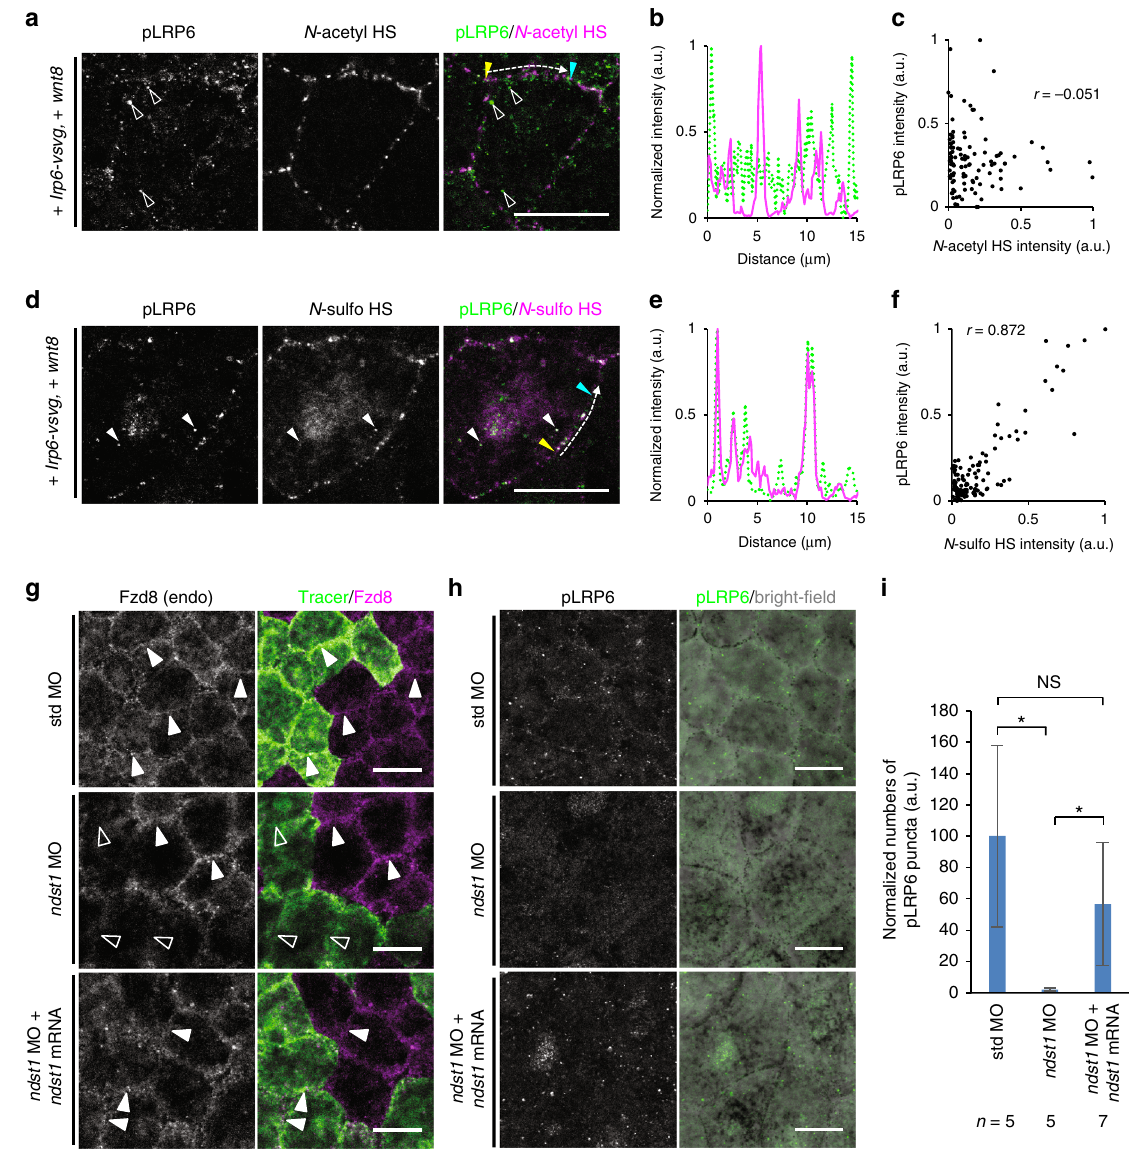
Fig. 8 N- sulfo-rich HS clusters are involved in the formation of the Wnt/LRP6 signalosome. a – f The colocalization of phosphorylated LRP6 (pLRP6) and N- sulfo-rich HS clusters. Together with Alexa Fluor 647-dextran (tracer, not shown), mRNAs of wnt8 and lrp6-vsvg were injected into the animal pole region of a ventral blastomere of 4- or 8-cell stage embryos. Signal intensities along white arrows were plotted ( b , e ), starting (yellow arrowheads) and ending (cyan arrowheads) points as indicated, respectively ( a , d ). Distributions of pLRP6 and N- acetyl HS were not correlated well (correlation coef fi cient r = − 0.051), whereas distributions of Wnt8 and N- sulfo HS were highly correlated ( r = 0.872). Note that pLRP6 staining is colocalized with N- sulfo HS staining on the membrane and also inside cells (white arrowheads) but not with N- acetyl HS staining (open arrowheads). g Requirement of ndst1 for the membrane distribution of endogenous Fzd8. Experimental procedures are essentially the same as in Fig. 6c. Immunostaining was carried out with the anti-Fzd8. std MO, as a negative control, did not affect Fzd8 accumulation at the cell boundary (white arrowheads), whereas ndst1 MO cell- autonomously reduced Fzd8 accumulation at the cell boundary (open arrowheads). Coinjection of ndst1 mRNA recovered Fzd8 accumulation at the cell boundary (white arrowheads). h Requirement of ndst1 for the phosphorylation of LRP6. mRNAs of lrp6 , wnt8 , and ndst1 (for rescue experiment only, bottom) and indicated MO were injected into the animal pole region of a ventral blastomere of 4- or 8-cell stage embryos. Punctate staining of pLRP6 was impaired by ndst1 MO, which was rescued by ndst1 mRNA. i Quanti fi cation of pLRP6 puncta. Graph, mean ± s.e.m. Signi fi cance level, ** p < 0.01 (multiple comparison with pairwise Wilcoxon rank sum test). Numbers of analyzed images ( n ) are as indicated. See Methods for details. Xenopus embryos (st. 11.5) were fi xed, stained, and analyzed. Images are a representative of at least two independent experiments. Amounts of injected mRNA (pg/embryo): lrp6-vsvg , 38; wnt8 , 250; ndst1 , 15 ( h ) or 6.7 ( g ). Amounts of injected MOs (ng/embryo): 28 ( g ), or 14 ( h ). Scale bars, 20 μ m. a.u., arbitrary colocalization of Wnt8 with HS clusters was further con fi rmed by clusters are not frequently internalized (Fig. 5a), intracellular ndst1 overexpression; while mV-Wnt8 alone accumulated on the puncta of mV-Frzb were much fewer than those of mV-Wnt8 ndst1 -overexpressing cells, mV-Wnt8 together with Frzb was not (Fig. 10b, left and middle), but, in the presence of Frzb, the localized on the cell boundary between two ndst1 overexpressing intracellular puncta of mV-Wnt8 were reduced (Fig. 10b, right). cells (Fig. 10a). Consistent with the fact that N- acetyl-rich HS These data suggest that Frzb inhibits the internalization of Wnt8